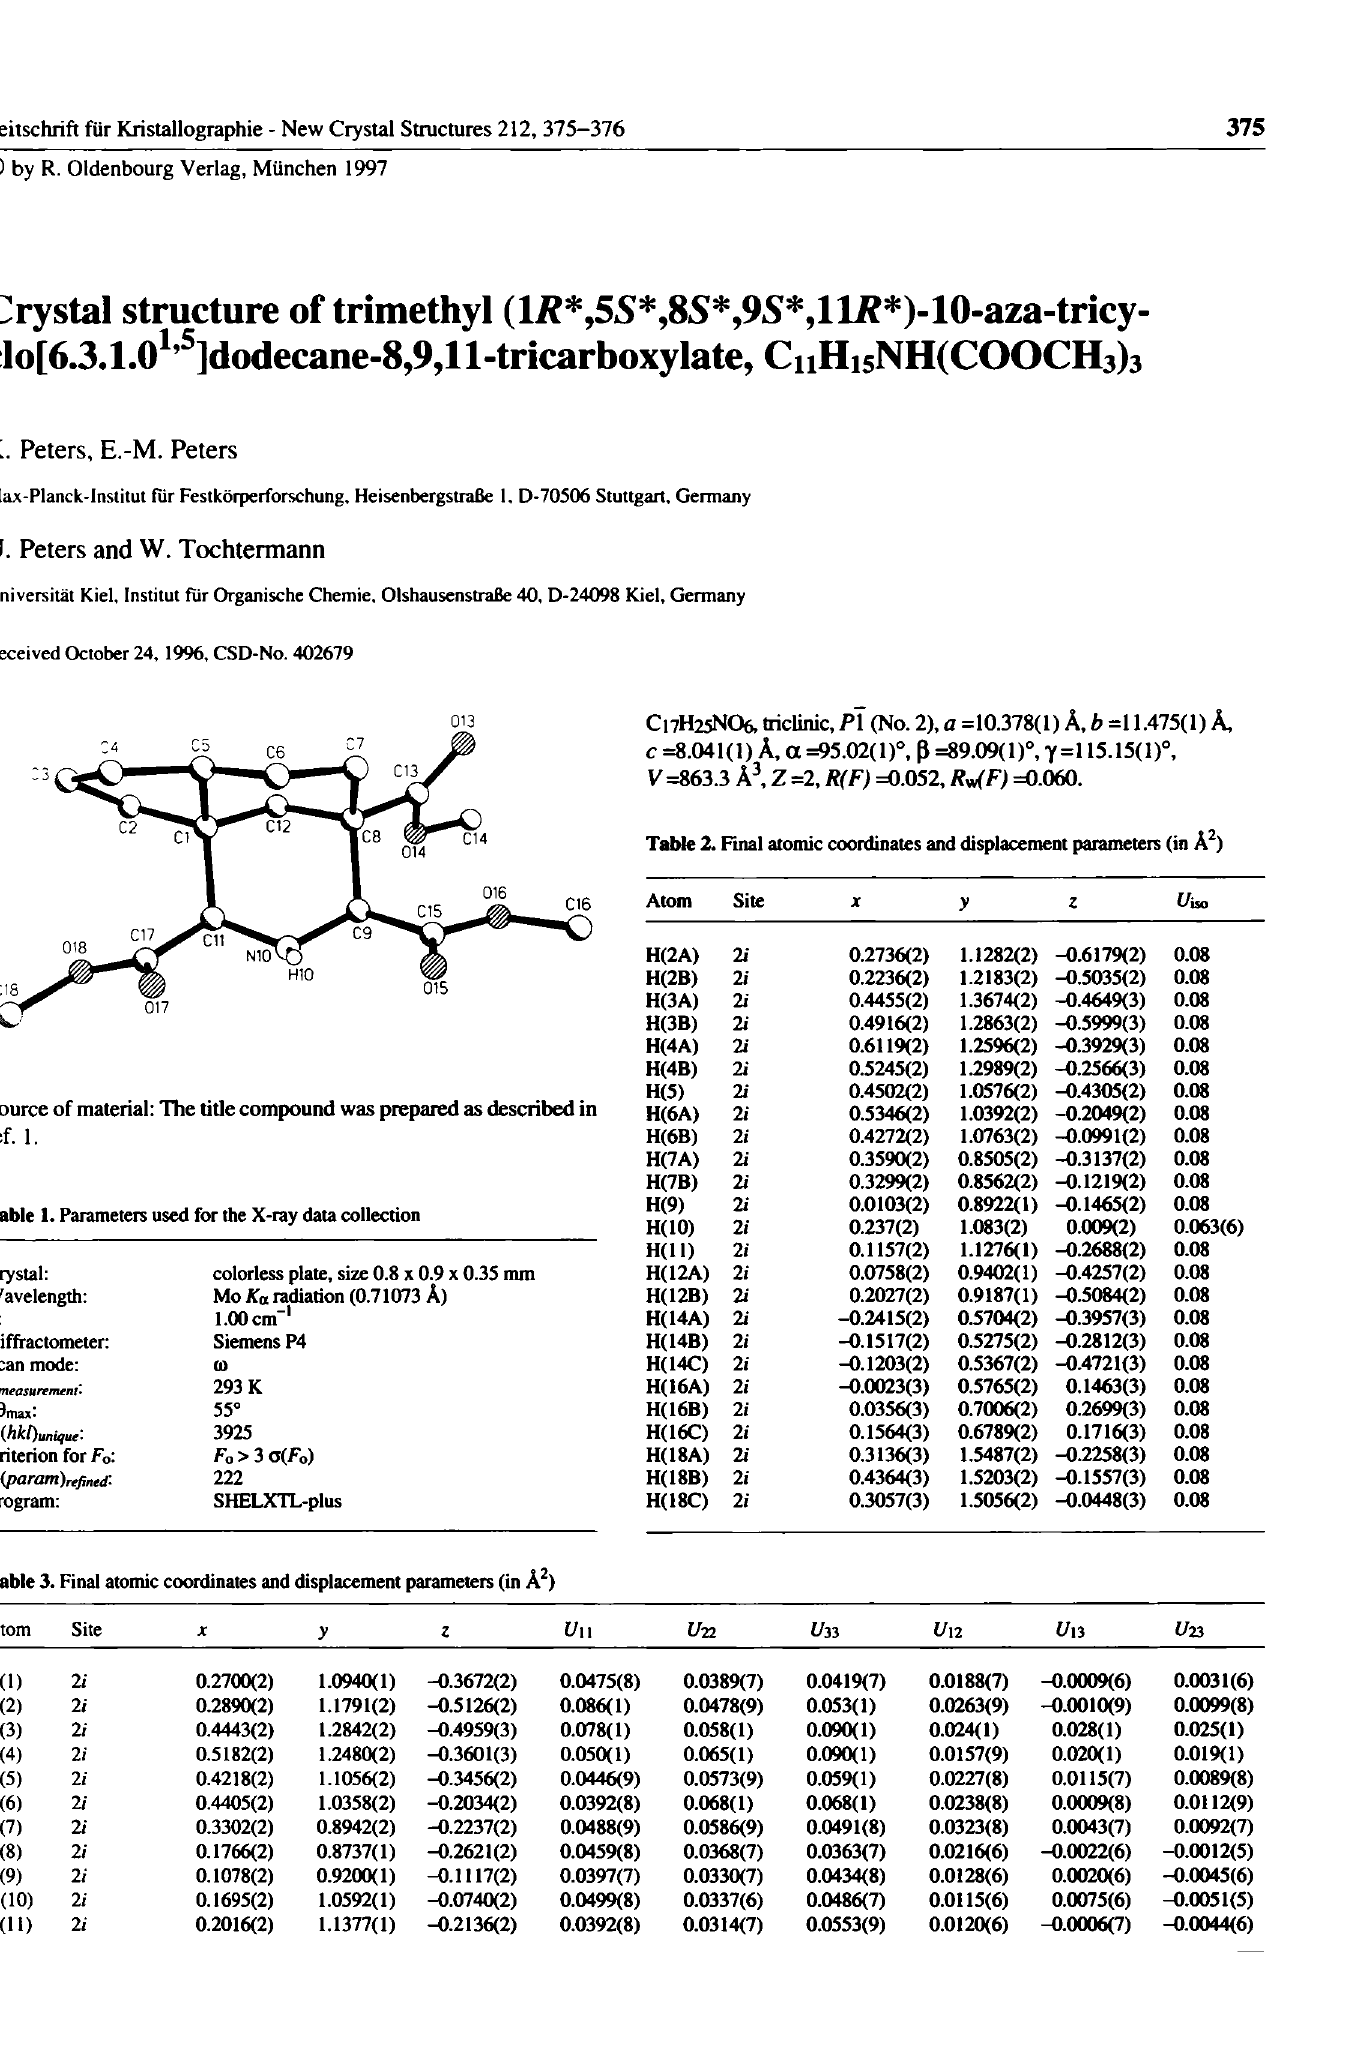
Table 1. Parameters used for the X-ray data collection